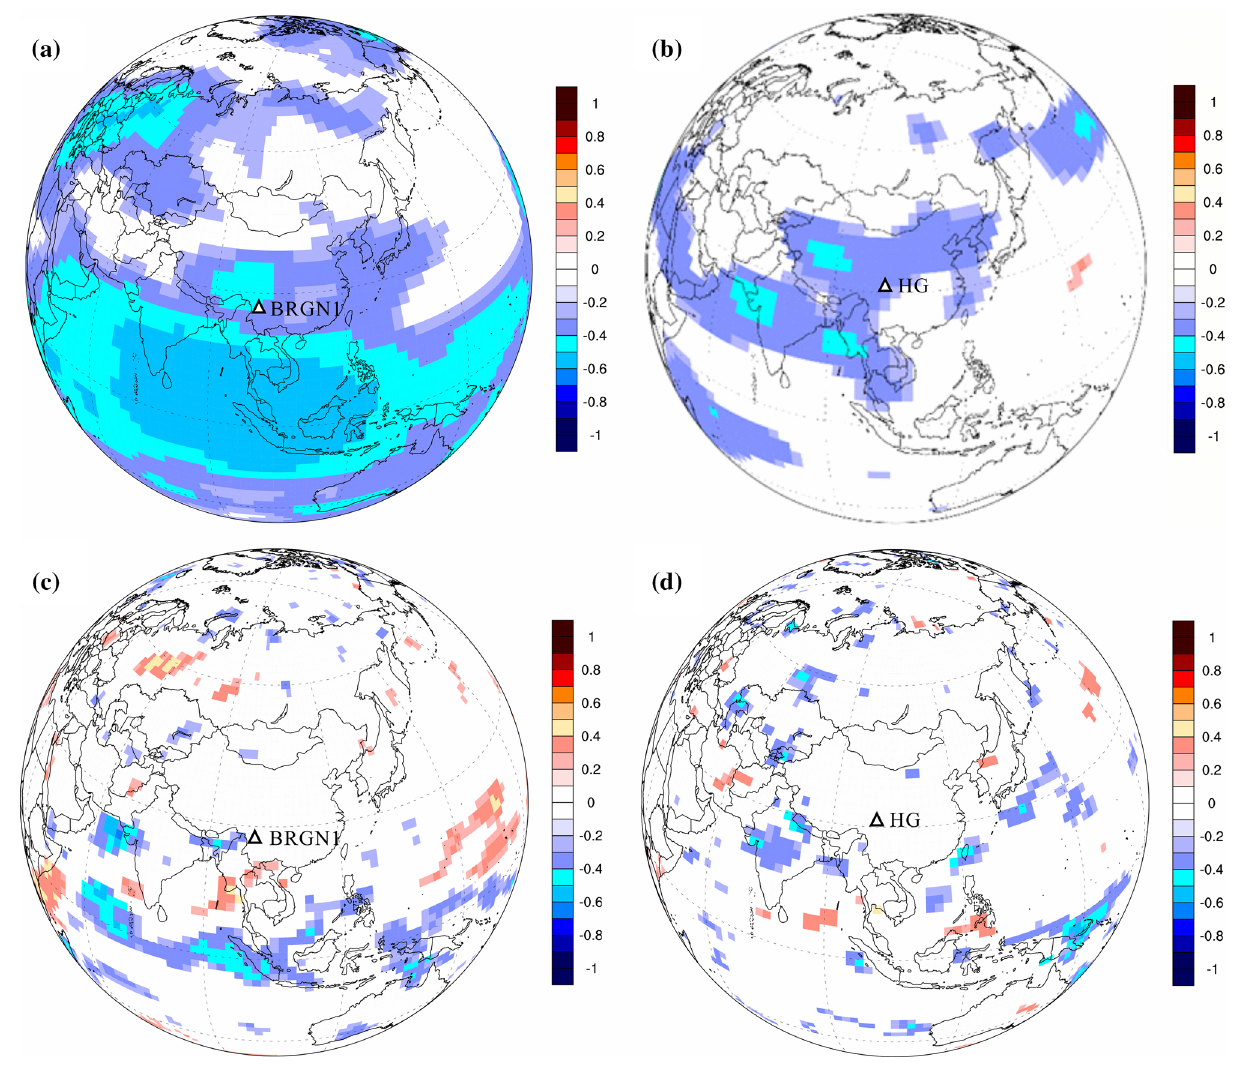
Figure 7. Spatial correlation (≥ 95% confidence level) between 500 hPa temperature and mass balance in Baishui River Glacier No. 1 (BRGN1) ( a , 1958–2016) and Hailuogou Glacier (HG) ( b , 1959–2008), and total precipitation and mass balance in the BRGN1) ( c ) and HG ( d ) (the bars in the figure represent correlation). The maps were created by NCL Version: 6.6.2 (http://www.ncl.ucar.edu/citat ion.shtml